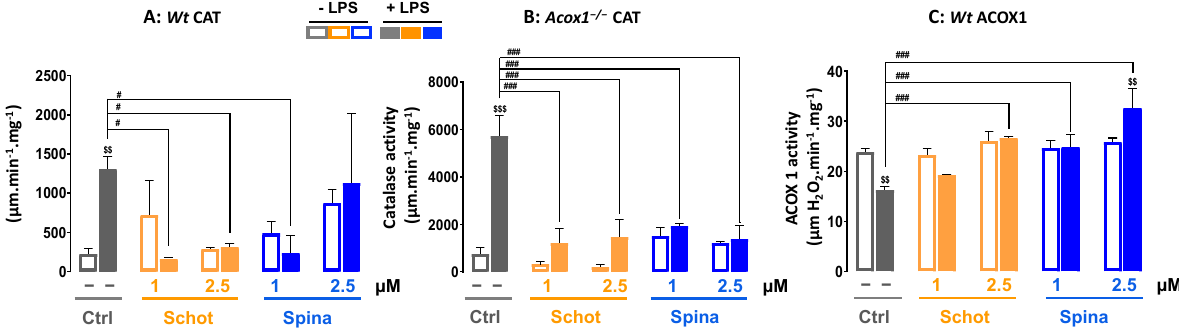
Figure 5. Effect of Schot and Spina on catalase activity in the Wt ( A ) and Acox1 − / − ( B ) BV-2 microglial cells, and on ACOX1 activity ( C ) in Wt BV-2 microglial cells. Cells were incubated for 24 h with Schot or Spina (1 or 2.5 µM) in the absence or the presence of LPS (1 µg/mL). All values are presented as means ± SD of two independent experiments performed in triplicate, with the statistical significance of the increased mean signal indicated as ### p ≤ 0.01 and # p ≤ 0.05 compared to LPS and $$$ p ≤ 0.001 and $$ p ≤ 0.01 compared to the different treatments with or without LPS administration. Statistical significance was determined using two-way ANOVA followed by Tukey’s test for multiple comparisons.